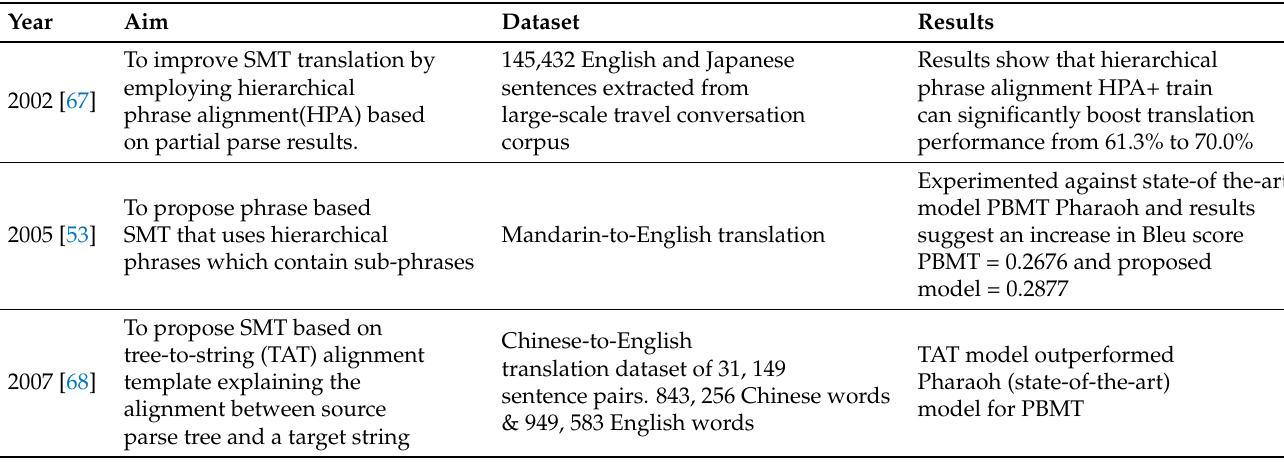
Table 4. Survey of hierarchically based machine